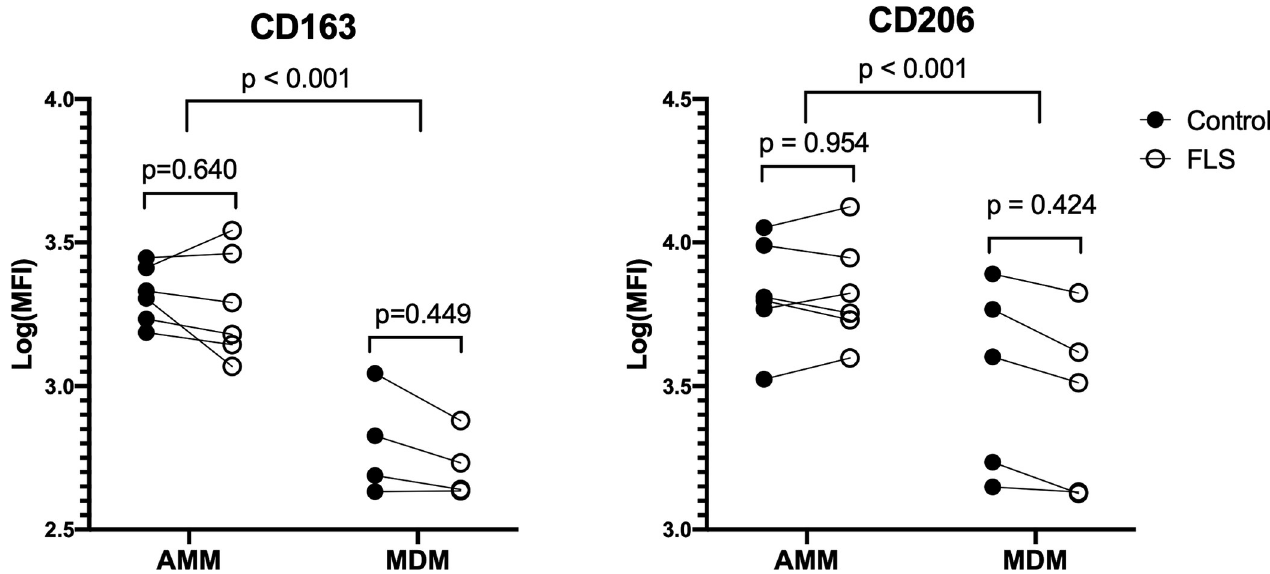
Fig 1. Cell surface expression of CD163 and CD206 on alveolar macrophages/monocytes and monocyte-derived macrophages exposed to an inflammatory stimulus (FLS). There was higher expression of CD163 and CD206 on AMMs than MDMs independent of culture conditions. Expression of CD163 and CD206 was not changed in FLS-exposed AMMs, and although reduced in MDMs, the decrease was not statistically significant. The median fluorescence intensity (MFI) value was log transformed.